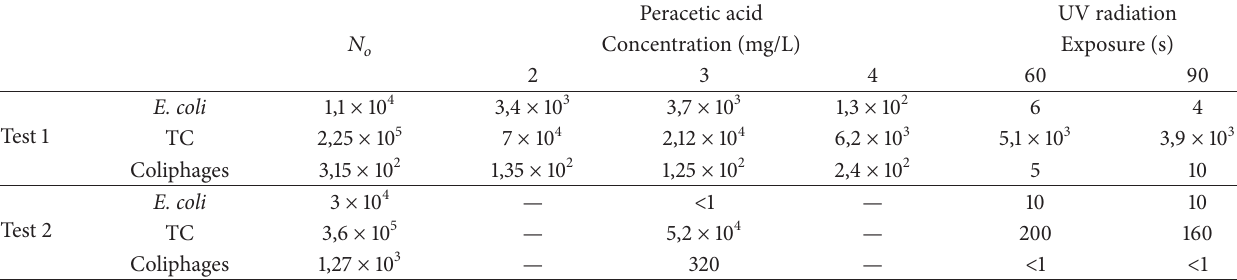
Table 1: E. coli , TC, and coliphages inactivation employing, individually, PAA and UV radiation in tests with wastewater. Peracetic